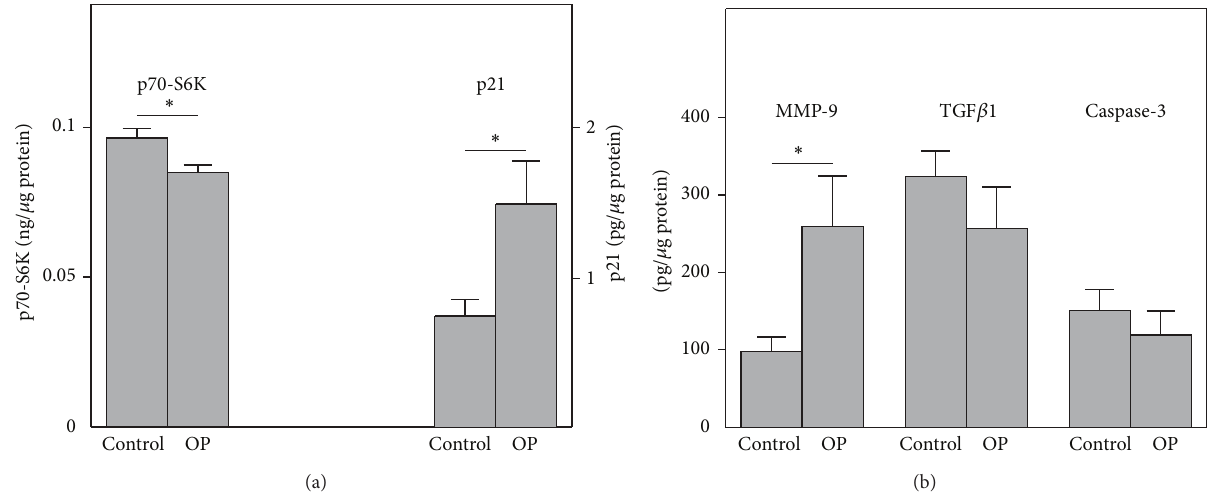
Figure 2: Protein concentrations of p70-S6K, p21 (a), MMP-9, TGF 𝛽 1, and caspase-3 (b) measured by ELISA in the PBMCs from OP patients ( 𝑛 = 22 ) compared with the control subjects ( 𝑛 = 26 ). Asterisks indicate significant differences from the healthy control subjects.